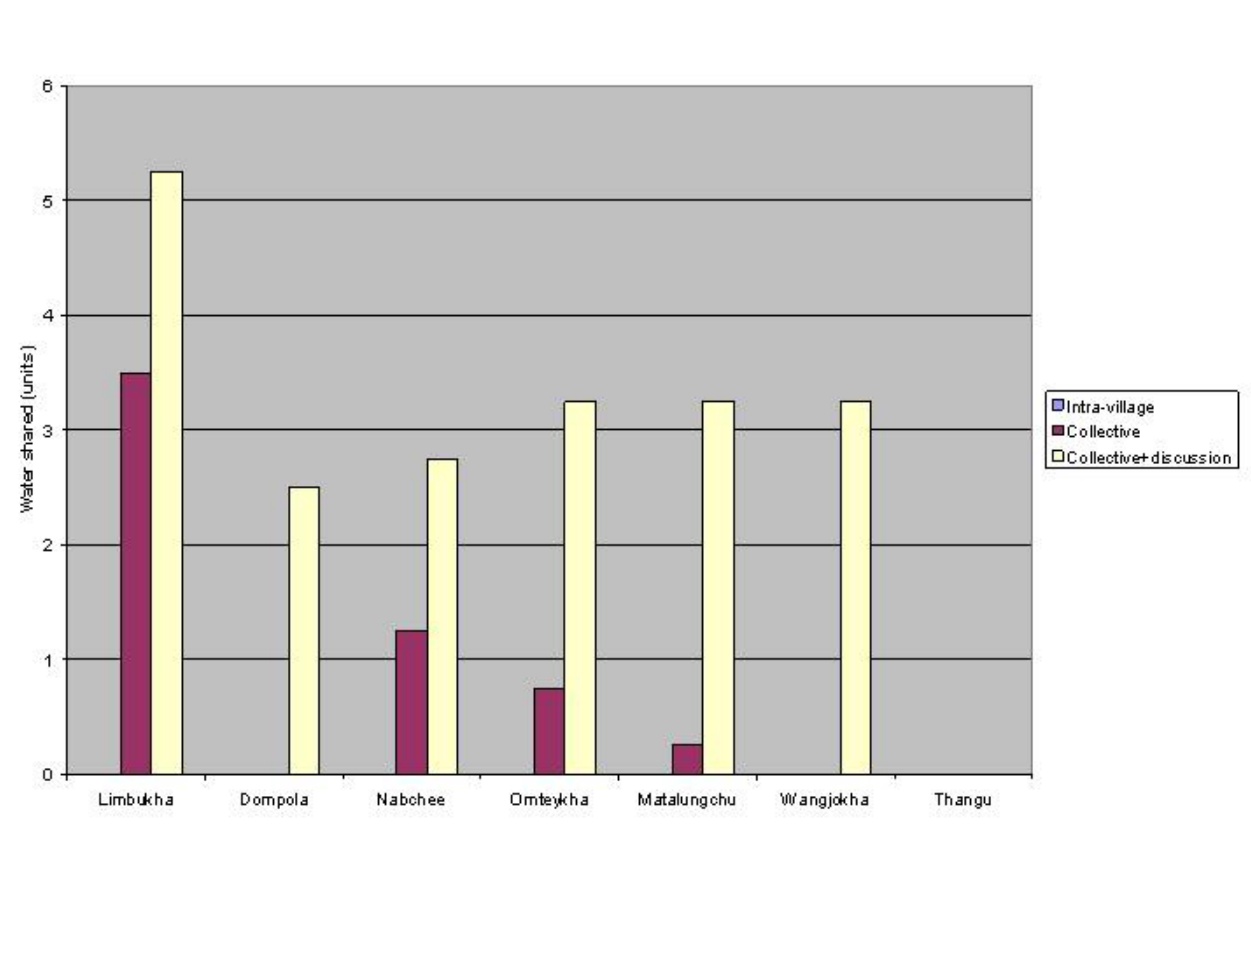
Fig. 11. Water shared by the seven villages according to the various communication modes (average for four